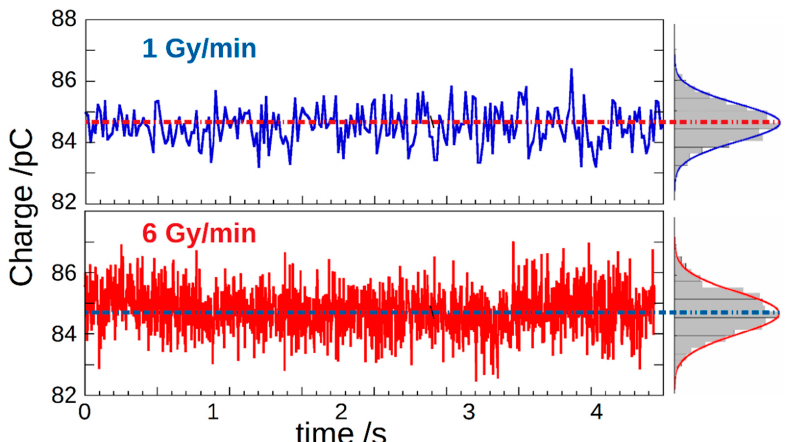
Figure 5. Charge-per-pulse values versus time measured at different DRs. Histograms on the right show their amplitude distribution. Table 1. Collected charge-per-pulse at different dose rates. Dose Rate (Gy/min)